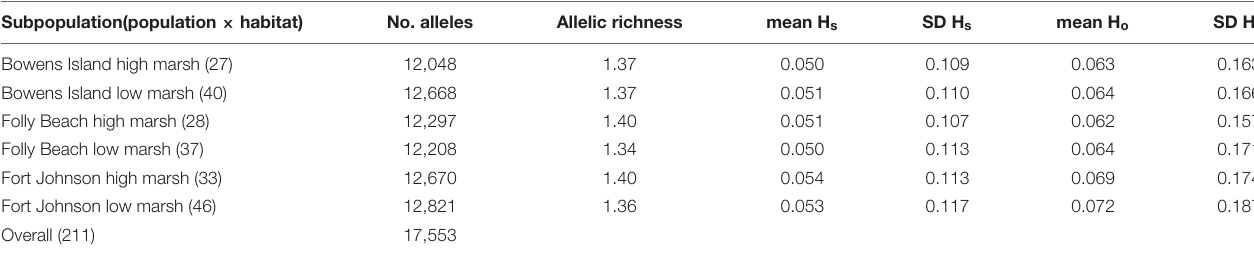
TABLE 1 | Number of alleles, allelic richness (i.e., average number of alleles per locus) and mean and standard deviation (SD) of observed gene diversity (H s ) and observed heterozygosity (H o ) per locus for each